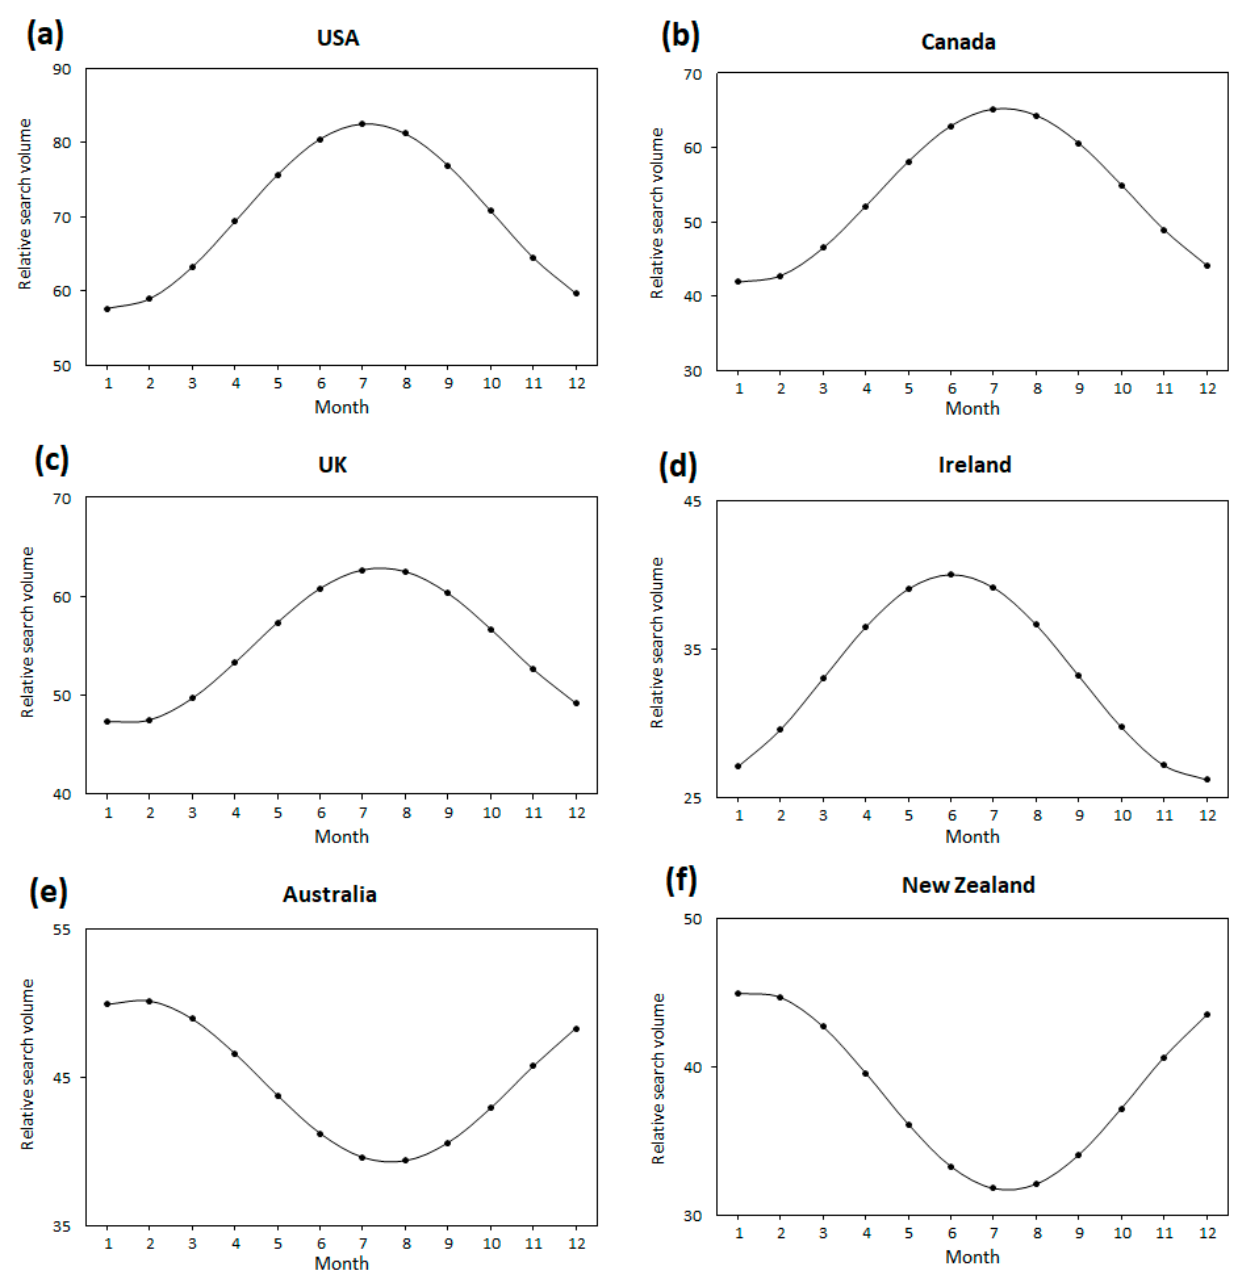
Figure 2. The plots of the cosinor model for seasonality in Google Trends search volume data for “heel pain” in ( a ) the USA, ( b ) Canada, ( c ) the U.K., ( d ) Ireland, ( e ) Australia, and ( f ) New Zealand. The numbers correspond to the months as follows: 1 = January; 2 = February; 3 = March; 4 = April; 5 = May; 6 = June; 7 = July; 8 = August; 9 = September; 10 = October; 11 = November; 12 = December.